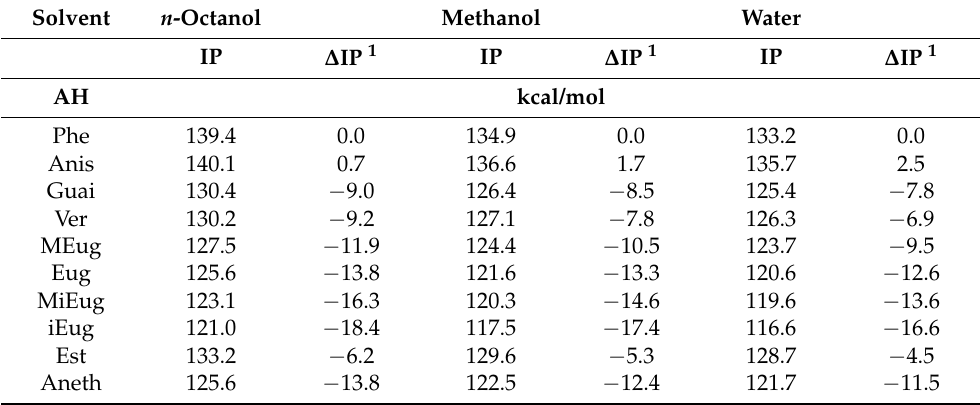
Table 3. Absolute and relative ( ∆ ) IP values (kcal/mol) of the test compounds in n -octanol, methanol, and water at B3LYP/6-31G//B3LYP/6-311++(2d,2p)